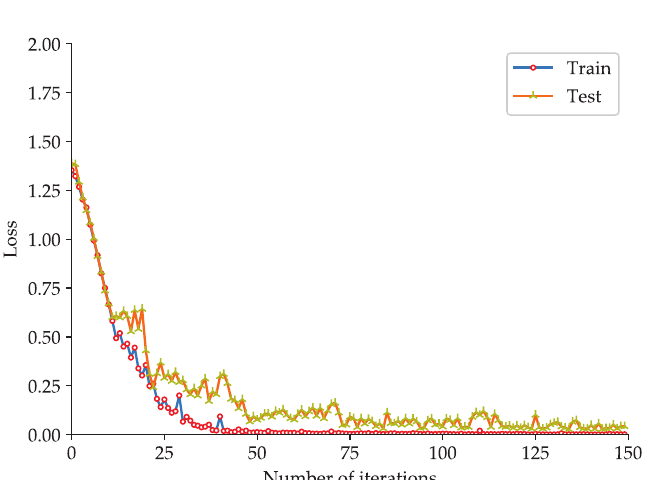
Figure 6. Loss function curve of the fault diagnosis model based on the improved 2D LeNet-5 network.